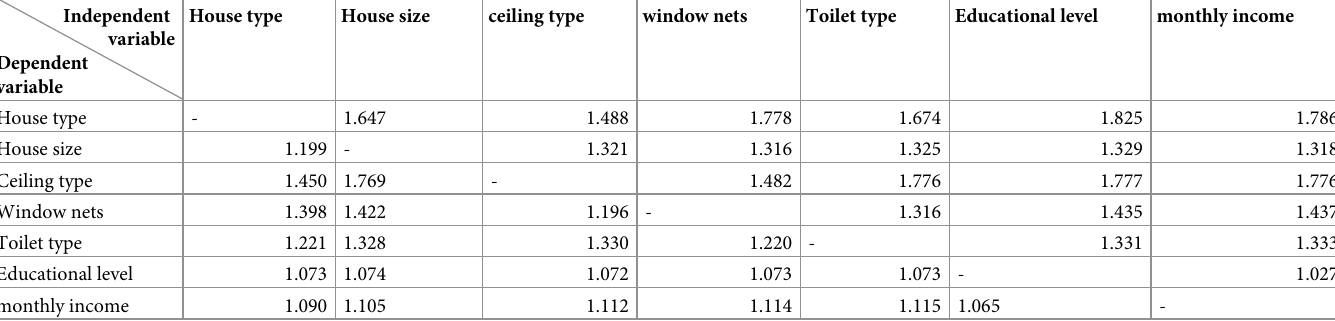
Table 2. Variance inflation factor values for multicollinearity of variables associated with income level in Nkongho-mbeng. Independent variable